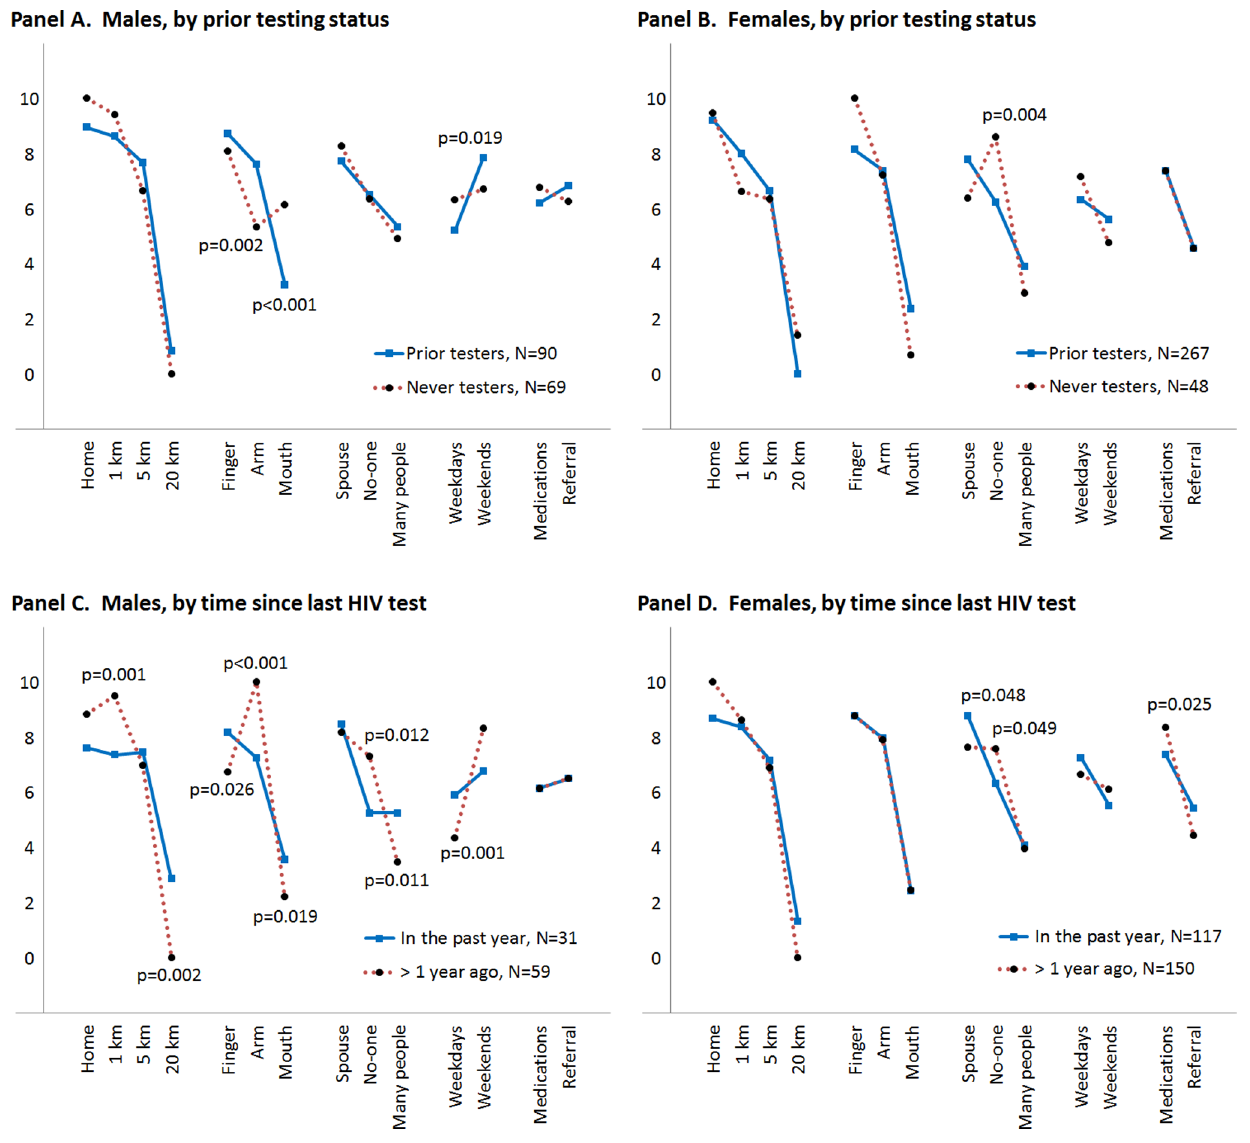
Figure 3. Scaled estimates of HIV testing preferences by gender, prior HIV testing status and time since the last HIV test. Gender- specific estimates of the effect of each attribute level on HIV testing preferences, separately for prior testers vs. those who never tested (Panels A and B), and those who tested in the past year vs. those who tested more than 1 year ago (Panels C and D). Models included correlated random main effects and fixed interactions between attribute levels and participants’ HIV testing histories. p-values indicate statistically significant differences between the respective groups, as measured by the interaction terms. Coefficients were re-scaled to range from 0 to 10.